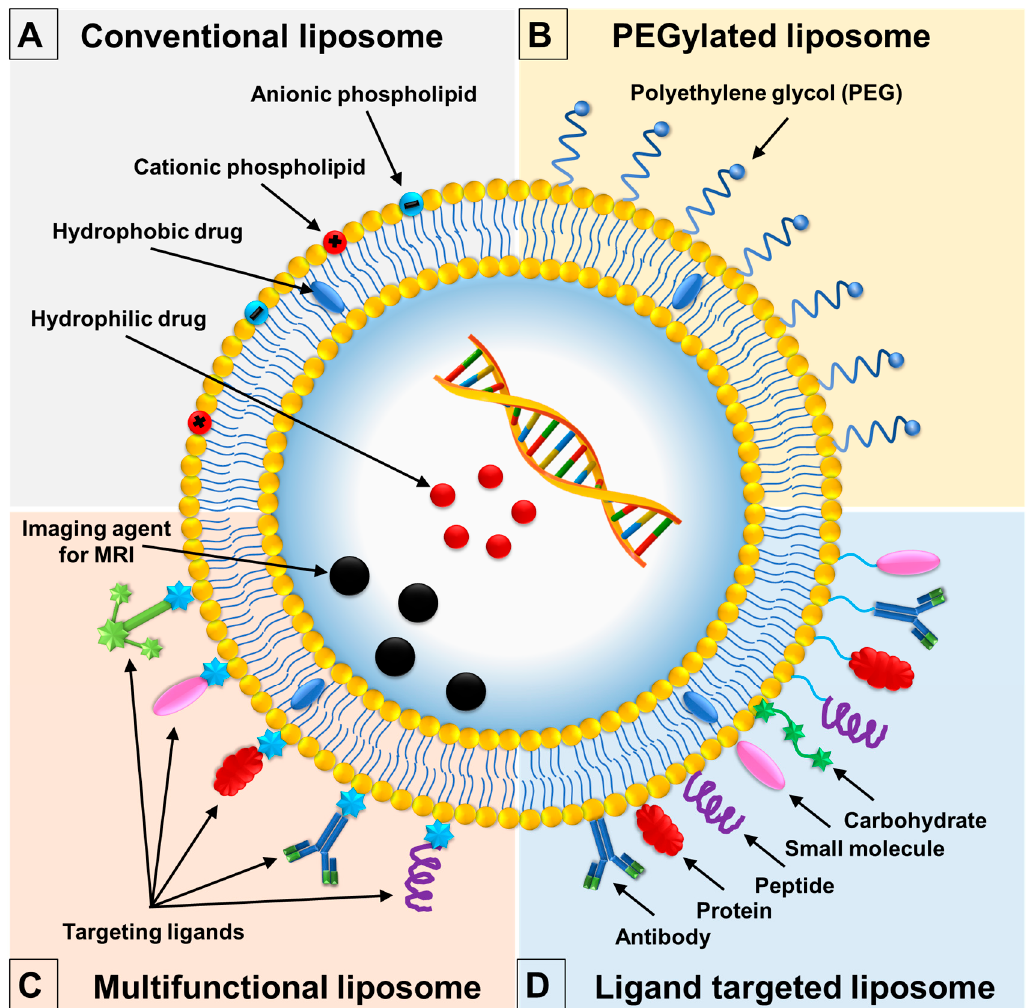
Figure 2. Classification of liposomes and the surface modification strategies applied in each category. ( A ) Conventional liposomes simply contain: neutral, anionic, and cationic phospholipids; ( B ) stealth liposomes are PEGylated contain a polyethylene glycol (PEG) layer; ( C ) multifunctional liposomes have modified surfaces in addition to carrying imaging agent for diagnostic purposes (diagnosis and treatment functions); and, ( D ) targeted liposomes have modified surfaces through the attachment of targeting ligands (antibody, protein, peptide, small molecule, carbohydrate). [21].